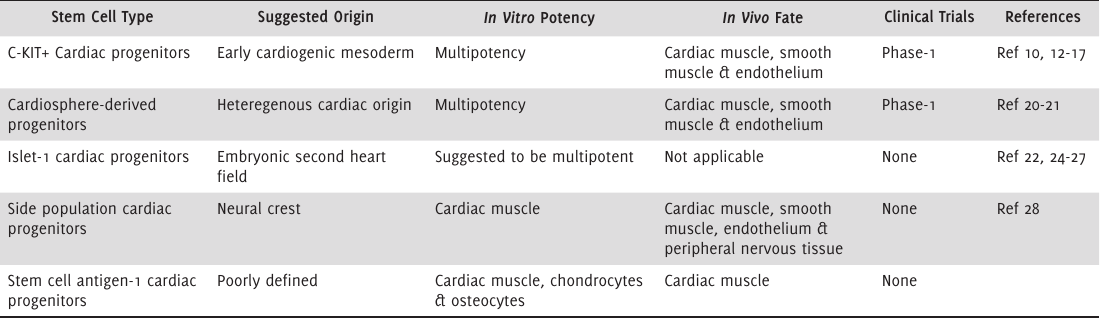
Table 1. Summary of Endogenous Stem Cell